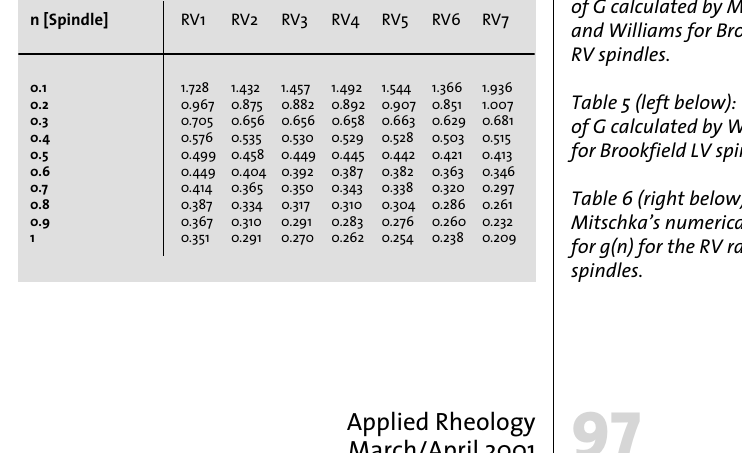
Table 4 (left above): Values of G calculated by Mitschka and Williams for Brookfield RV spindles. Table 5 (left below): Values of G calculated by Williams for Brookfield LV spindles. Table 6 (right below): Mitschka’s numerical values for g(n) for the RV range of